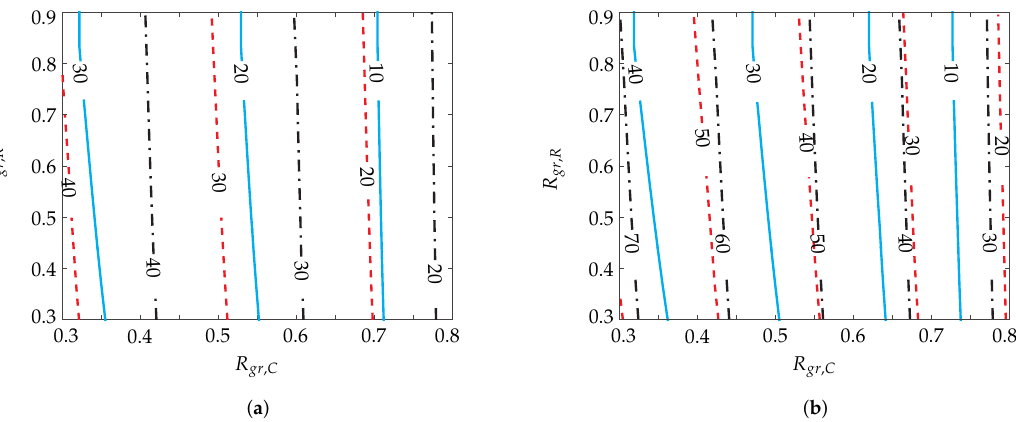
Figure 5. PPR frequency map as a function of the maximum central grating reflectivity R gr , C and the maximum right grating reflectivity R gr , R , for active section lengths L M = L S = 150µm ( a ) and L M = L S = 250µm ( b ). Three values of the grating coupling coefficient are considered: κ = 50cm − 1 (continuous lines), κ = 100cm − 1 (dashed lines) and κ = 200cm − 1 (dashed-dotted lines); the labels on the lines report the PPR frequency. The left grating maximum reflectivity is